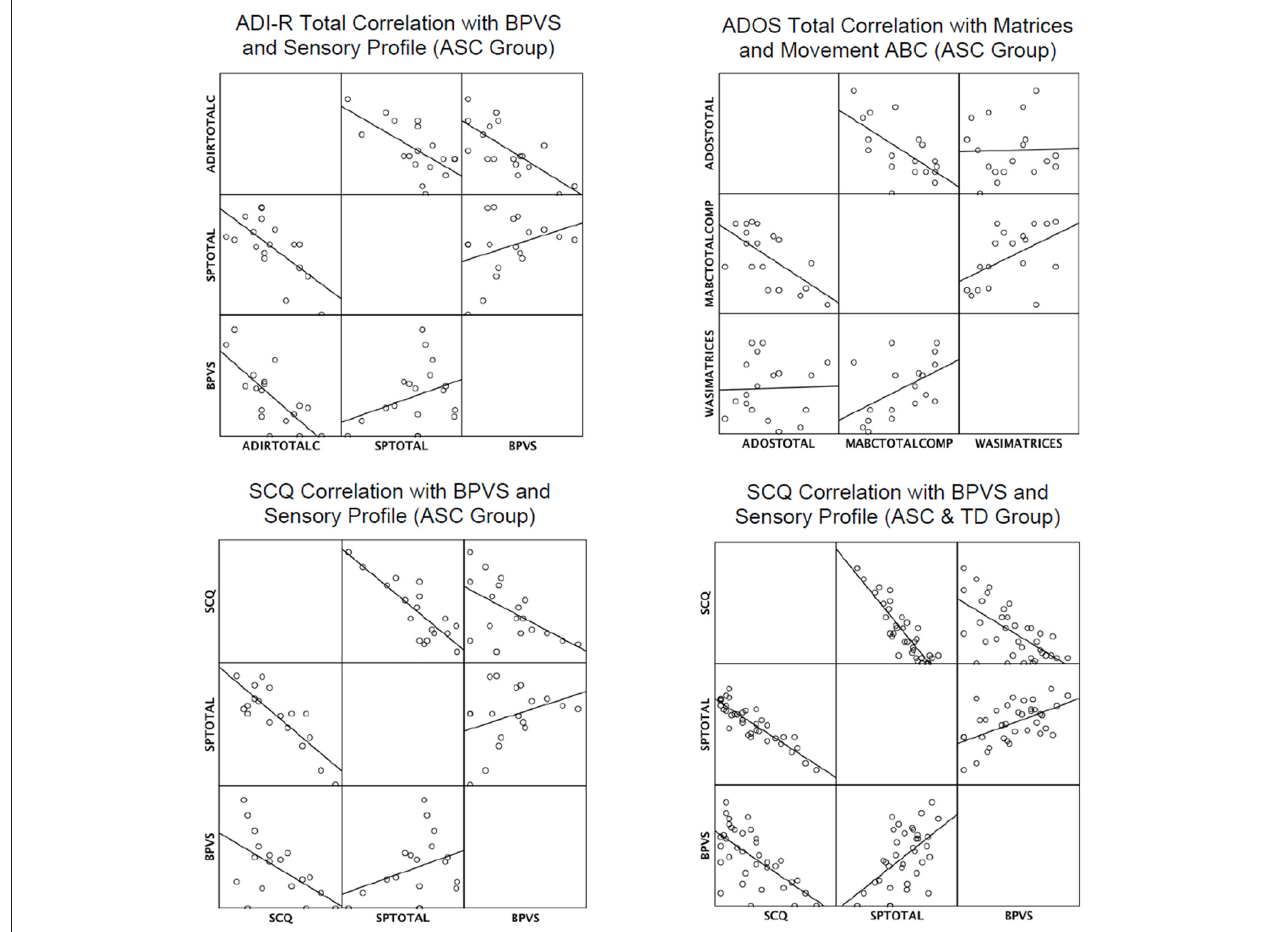
FIGURE 1 | Matrix scatterplots to show correlations in autism measures and retained predictors in multiple regression analyses. Key: ADIRTOTALC, ADI-R TOTAL Current; SPTOTAL, Sensory Profile Total; MABCTOTALCOMP, MovementABC Total Composite Score .